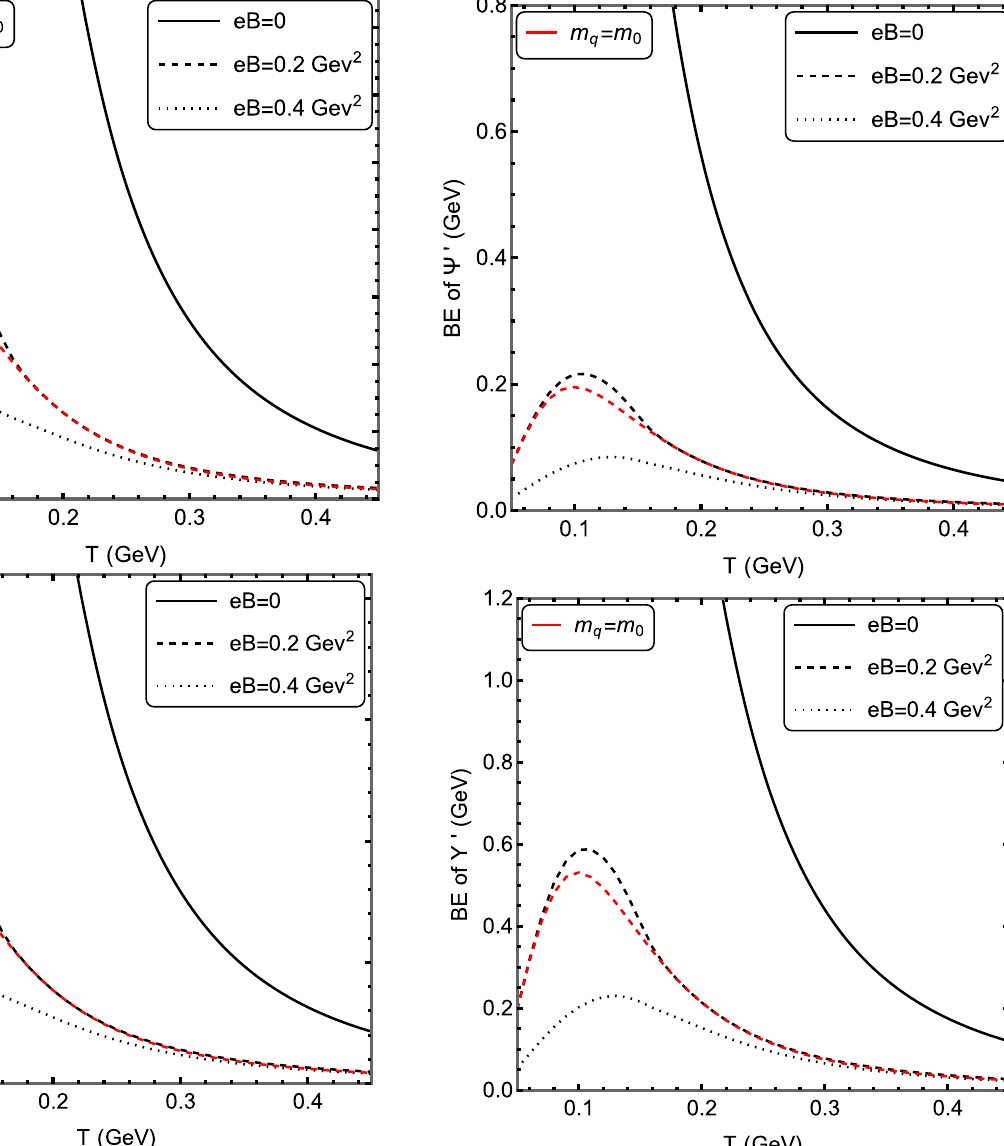
Fig. 5 Variation of binding energy (in GeV) with temperature with different values of magnetic field (eB) for J /ψ (left panel) and ϒ (right panel)